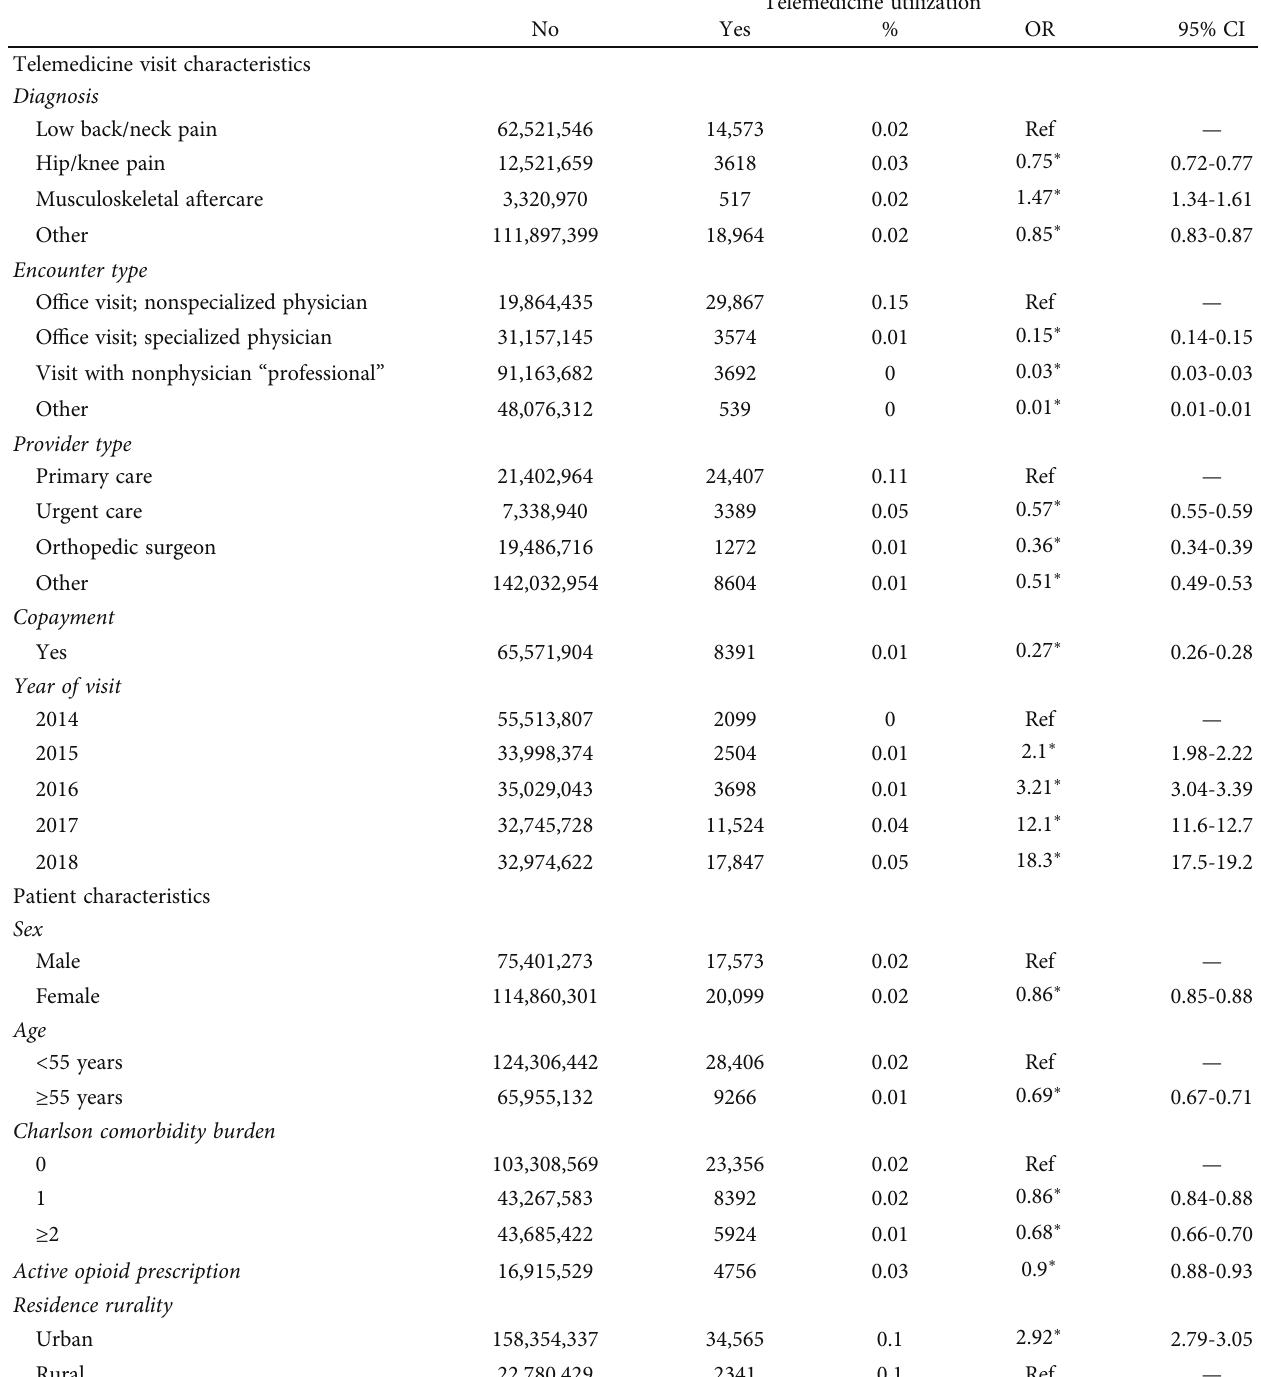
Table 1: Telemedicine use by study variables; absolute (unadjusted) numbers on the left and adjusted odds ratios with 95% con fi dence intervals on the